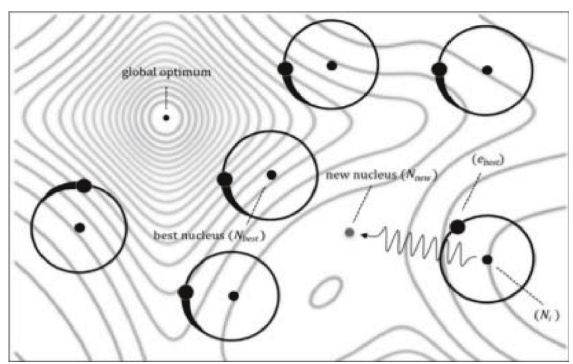
Figure 5: State diagram of nucleus